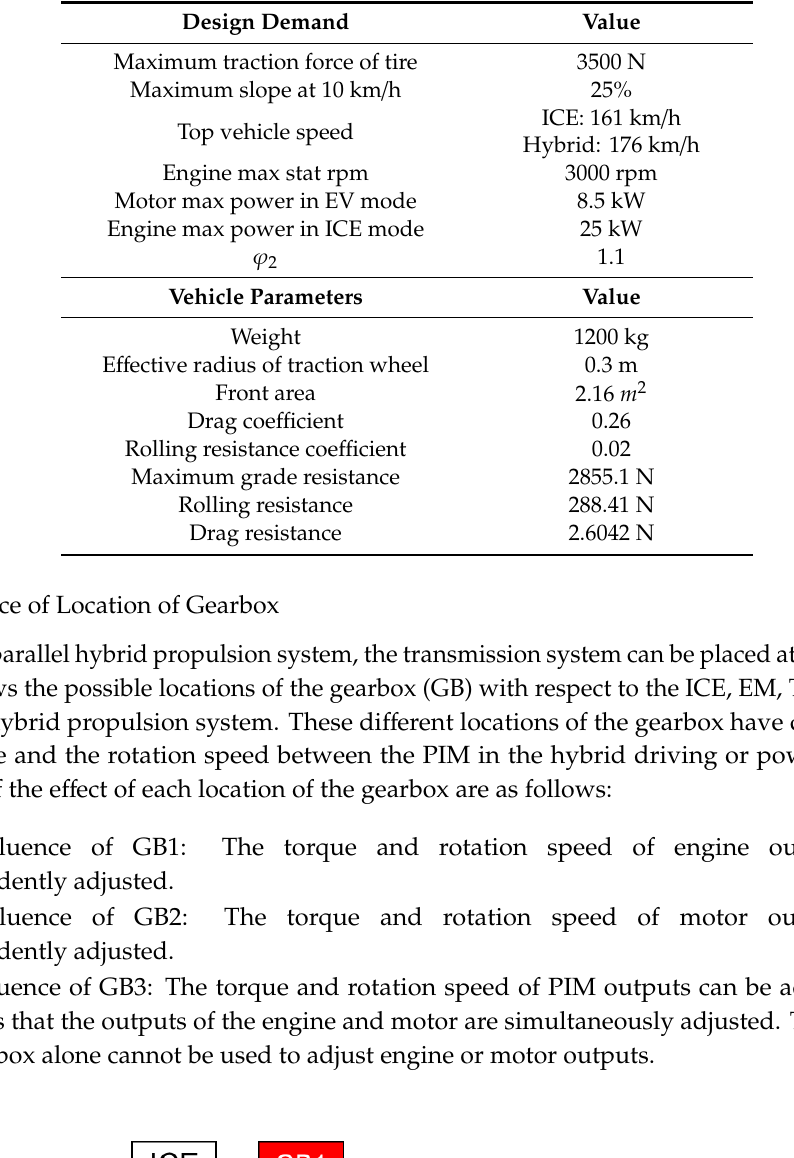
Table 2. Design requirement of transmission and corresponding parameters.